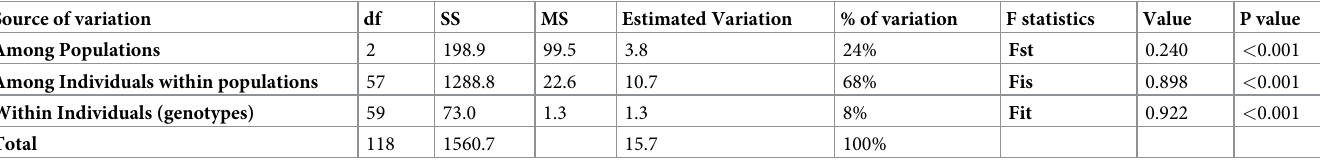
(YLD). Similarly, association analysis led to the identification of five SSRs with DFF, three each with PH, FG and TG, four each with TL, FLL and SLBR, seven SSRs with TGW, 13 SSRs with PL and 14 SSRs with FLW (Table 5, Fig 8). Table 4. Analysis of molecular variance (AMOVA) among and between